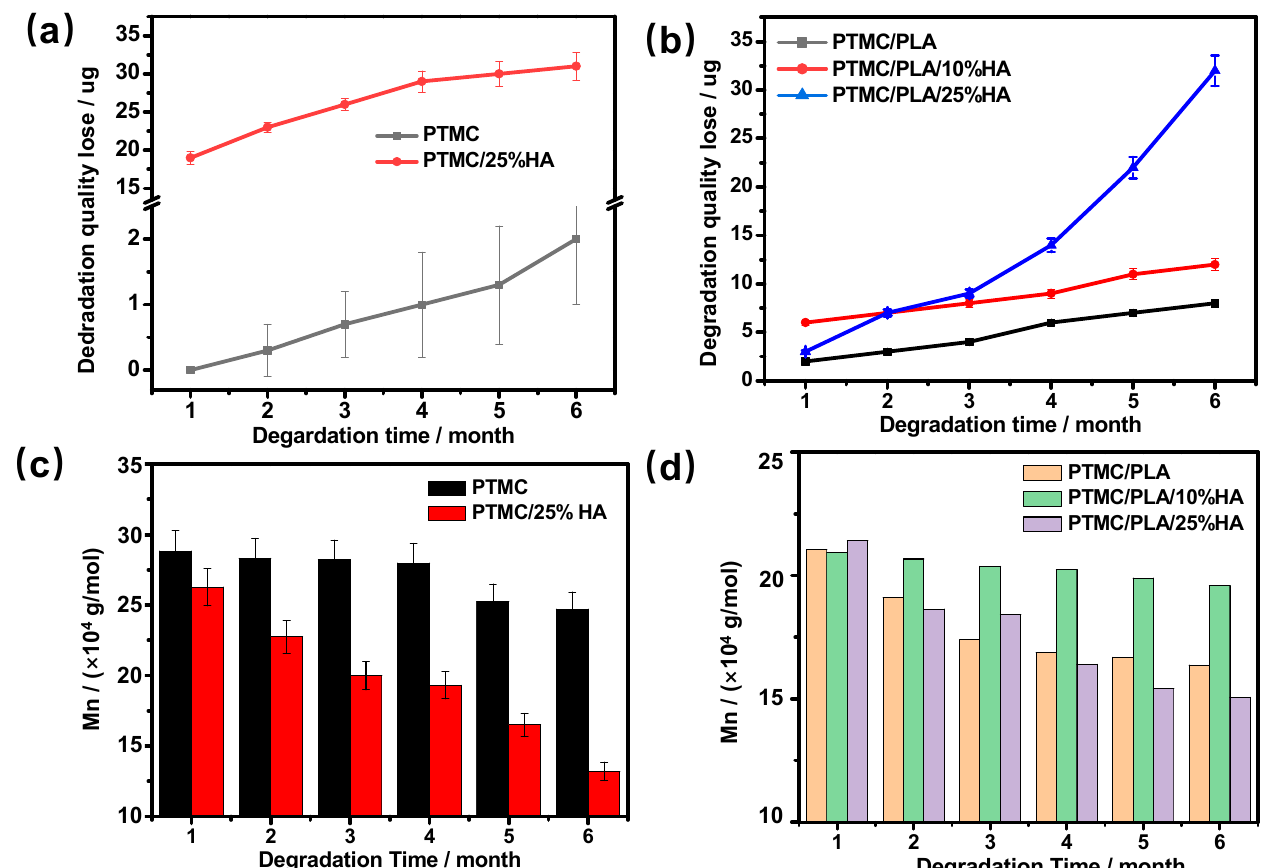
Figure 5. Weight loss ( a,b ) and number average molecular weight loss ( c,d ) of PTMC/PLA and PTMC/PLA/HA scaffolds. The molecular weight of PTMC/PLA and PTMC/PLA/25%HA scaffolds